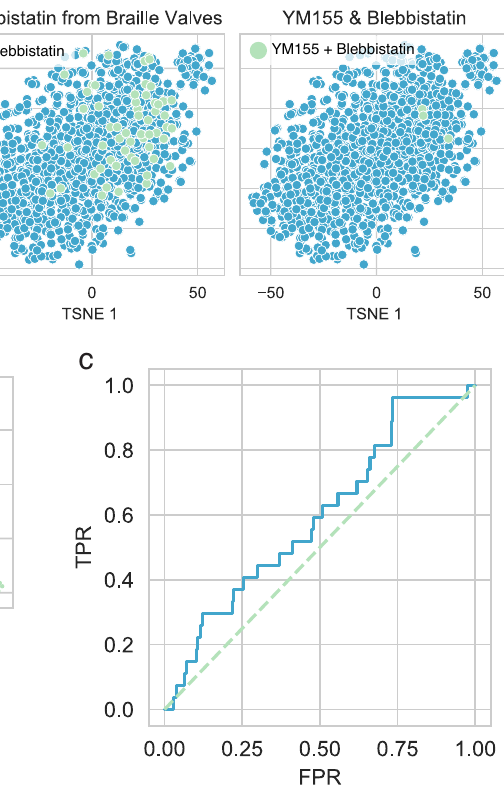
Fig. 5 | High-throughput gene expression-based combinatorial drug screen. a TSNE plots of normalized gene expression data. YM155 (left panel), Blebbistatin (middlepanel),andYM155-Blebbistatincombinationtreatedsamplesarelabeledas representative examples. b Silhouette scores of sample clustering based on auto- sampler/Braillevalvesdrugsandcombinations.Silhouettesscoresarecomparedto random distributions (color code) created by permuting sample labels. ( c ) ROC